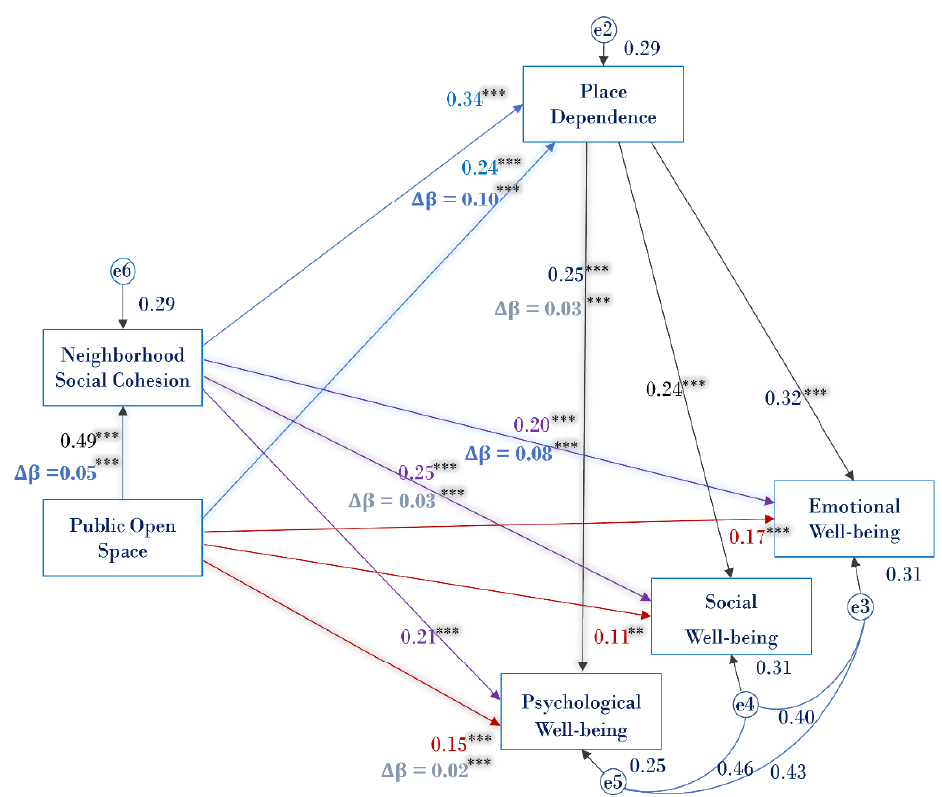
Figure 2. Structural equation model. ** p ≤ 0.01, *** p ≤ 0.001. Pathways highlighted in blue are stronger for the old-old group, and pathways highlighted in gray are stronger for the young-old group. Table 3. Results of construct reliability and validity.